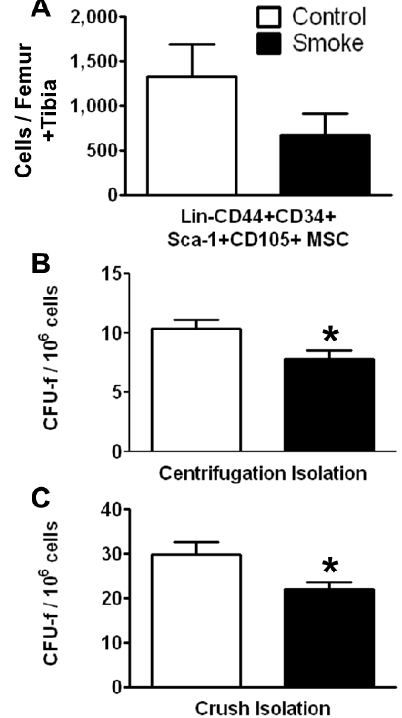
Figure 2. Smoke exposure decreases bone marrow mesenchymal stromal cells